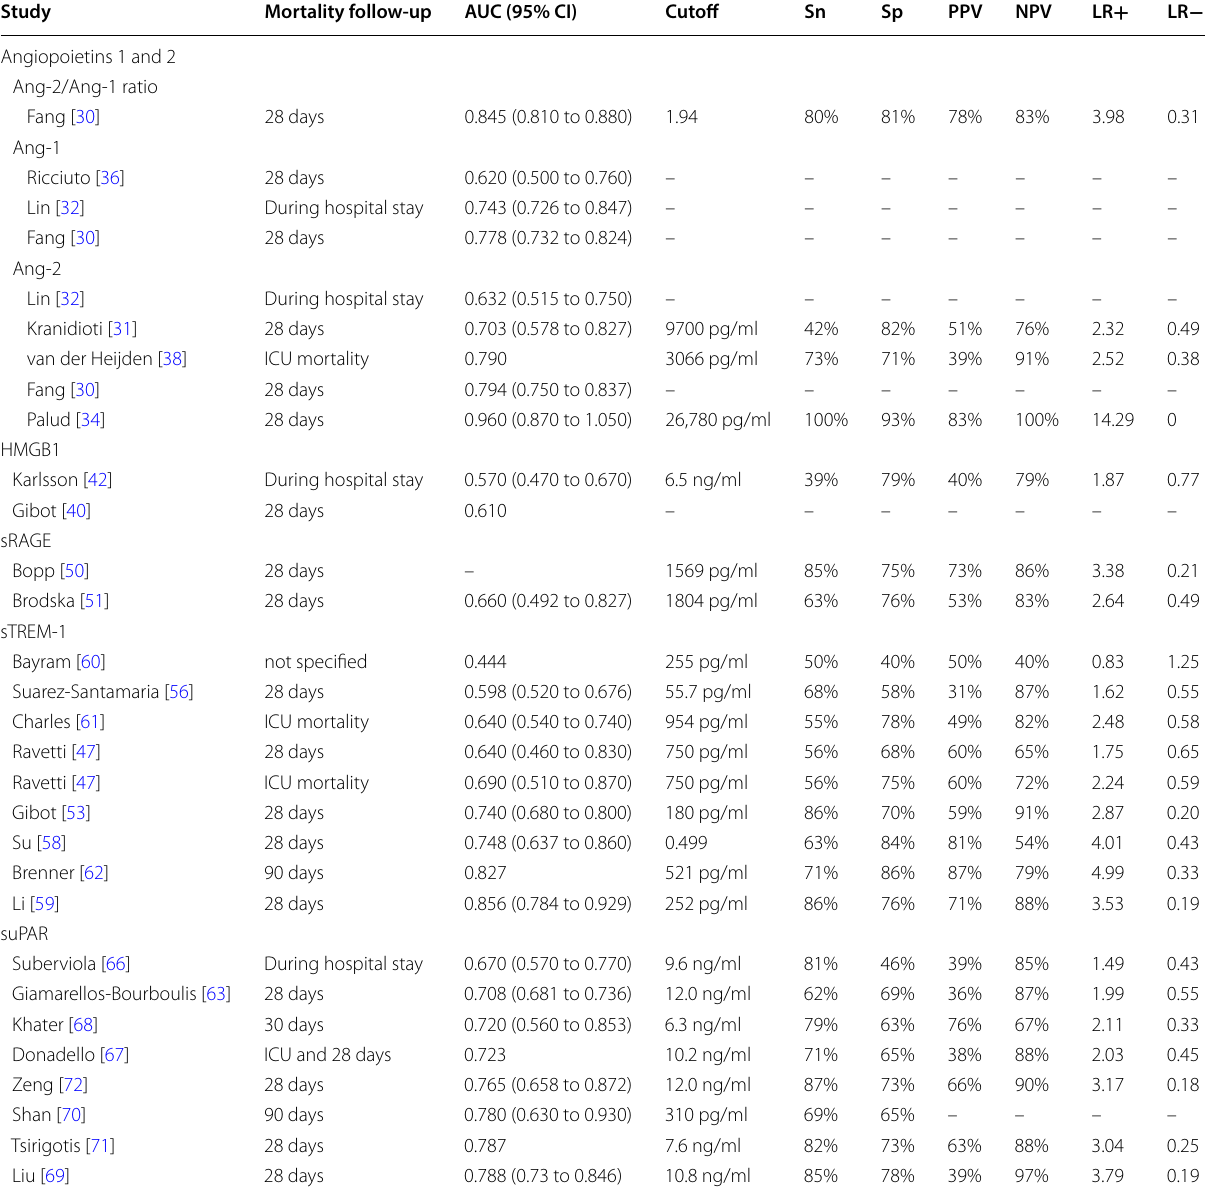
Table 2 ROC analyses for prediction of mortality according to baseline (< 24 h of admission) biomarker